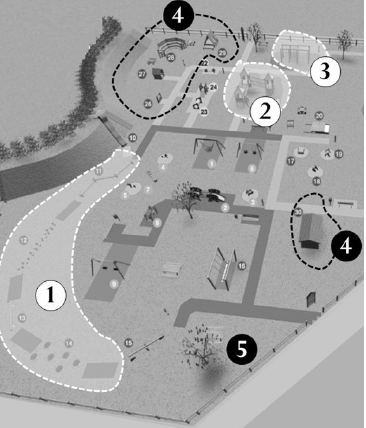
Figure 1. Layout of the playground Primo Sport 0246 and distribution of the specific areas. 1: balance area; 2: mobility area; 3: manual dexterity area; 4: symbolic play area; 5: mixed area.